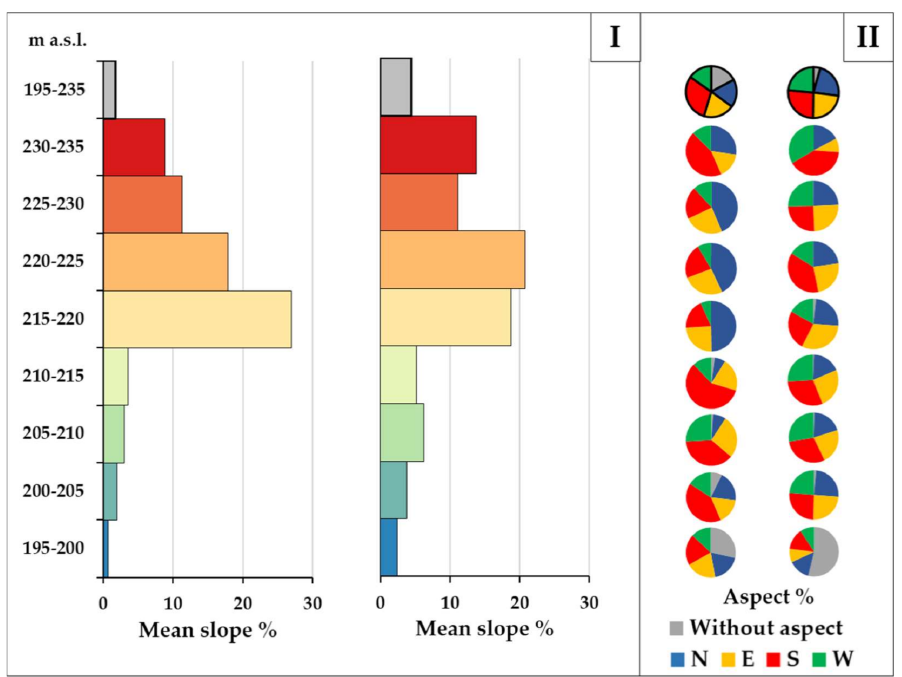
Figure 5. Topographic parameters of the areas in 5 m intervals in time variants ( I , II ): mean slope and % of the area without aspect and with N, E, S and W